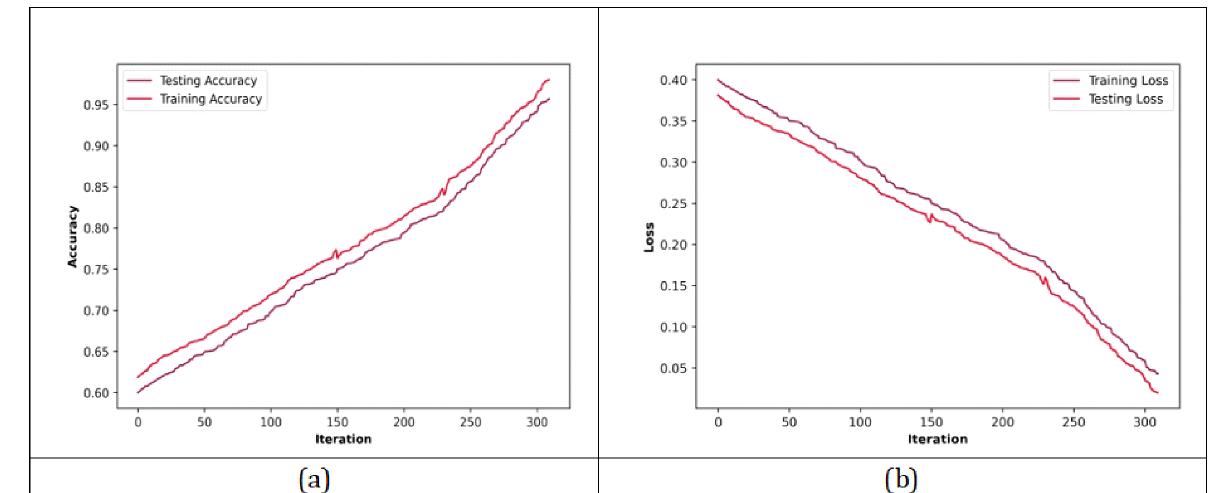
Figure 4. Performance analysis based on ( a ) accuracy and ( b ) loss for Sentiment Classification using IMDB dataset.